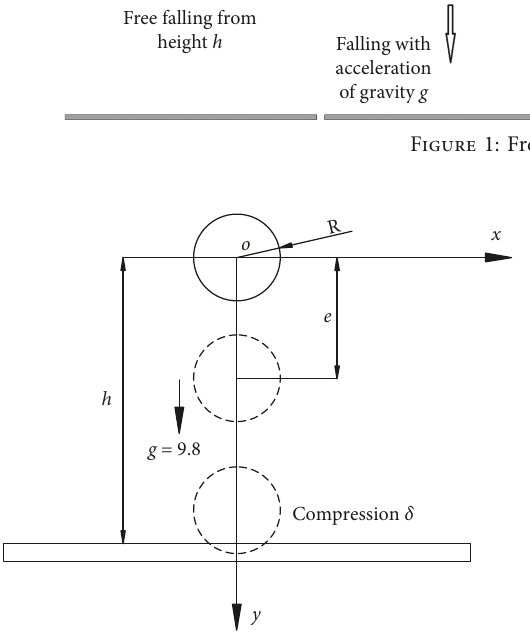
Figure 2: Impact schematic diagram between falling body and plate.